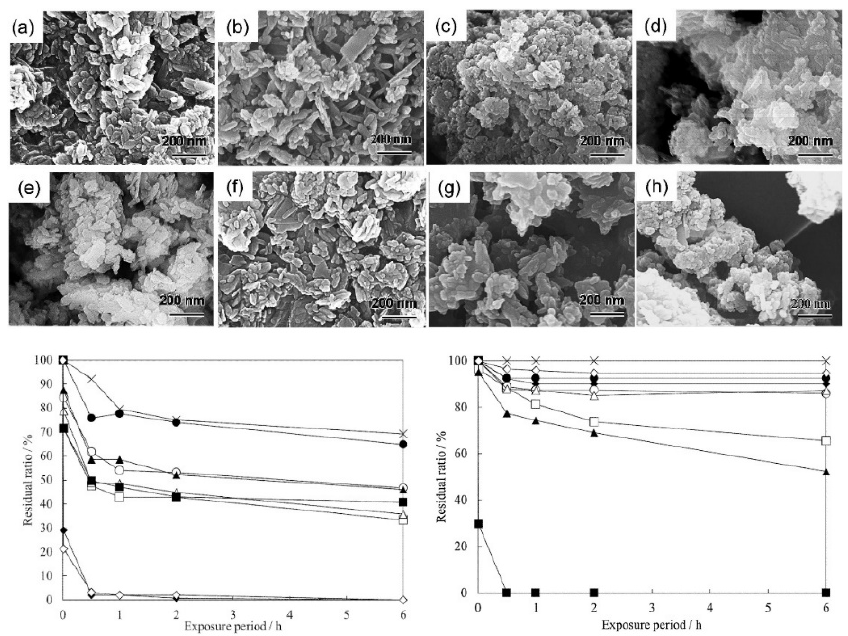
Figure 7. Scanning electron microscopy (SEM) micrographs of HA doped with ( a ) Ca, ( b ) Fe(II), ( c ) Fe(III), ( d ) Co, ( e ) Ni, ( f ) Cu, ( g ) Zn, and ( h ) Al. Below: adsorption of NH3 (lower left) or H 2 S (lower right) by HA doped with Ca (full circle), Co (empty circle), Zn (full triangle), Ni (open triangle), Cu (full square), Fe(II) (open square), Fe(III) (full diamond), and Al (open diamond). (©Elsevier. Reprinted with permission from [332].)